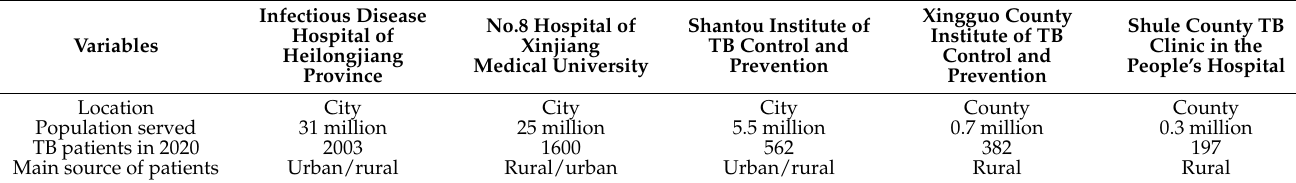
Figure 1. Location of the five health facilities in China. Table 1. Details of the five hospitals/clinics that were selected for post-TB assessment of patients who had successfully completed anti-TB treatment.